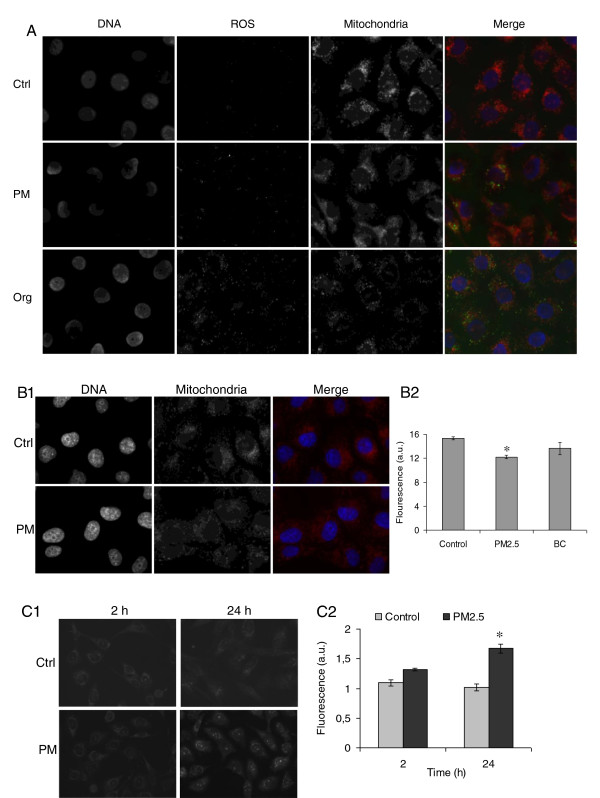
Analysis of mitochondrial damage. (A) ROS and mitochondria co-localization was assessed by fluorescence microscopy. BEAS-2B cells, exposed for 2 h to 7.5 μg/cm2 of winter PM2.5 and to its organic fraction, were stained for DNA, ROS and mitochondria. Co-localization signal of ROS and mitochondria was measured by Axiovision Rel 4.8 software as reported in materials and methods. (B) Mitochondrial damage in BEAS-2B cells exposed for 24 h to 7.5 μg/cm2 of winter PM2.5 was assessed by fluorescence microscopy (B1) and flow cytometry (B2). Flow cytometry results are reported as fluorescence arbitrary units (mean ± SEM of 3 independent experiments). Carbon black (CB) was used as reference control for carbonaceous particles effects. (C) Mitochondrial superoxide formation in BEAS-2B cells exposed for 2 and 24 h to 7.5 μg/cm2 of winter PM2.5 was assessed by fluorescence microscopy (C1) and flow cytometry (C2). Flow cytometer results are reported as fluorescence arbitrary units (mean ± SEM of 3 independent experiments). Hydrogen peroxide (1 mM) was used as positive control and reported 3.4 ± 0.11 and 12.6 ± 0.09 as fluorescence arbitrary units at 2 and 24 h, respectively. * Statistically significant difference from untreated cells (control), P < 0.05.